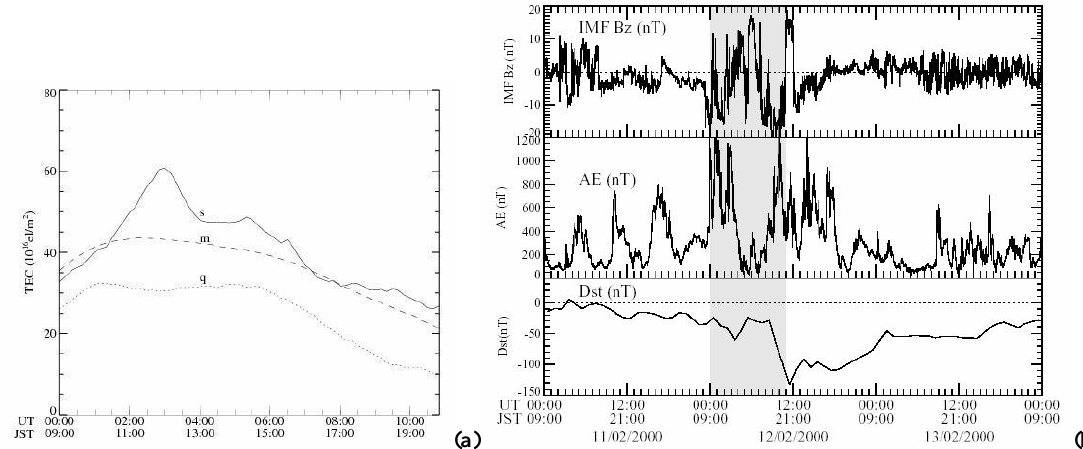
Fig. 1. (a) The comparison of typical temporal variations of storm-time (with a marking “s”) and quiet-time reference (with a marking “q”) TEC at 39 ◦ N (which is the longitudinal average along Japanese sector) with the IRI model values (with a marking “m”) and (b) temporal variations of Interplanetary Magnetic Field component (IMF B z ) , AE index, and D st during the period 11–13 February 2000. The shaded area in Fig. 1b corresponds to the duration considered for Fig.